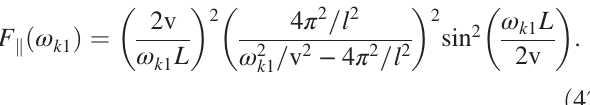
(solid line). Dashed line, no coherent p